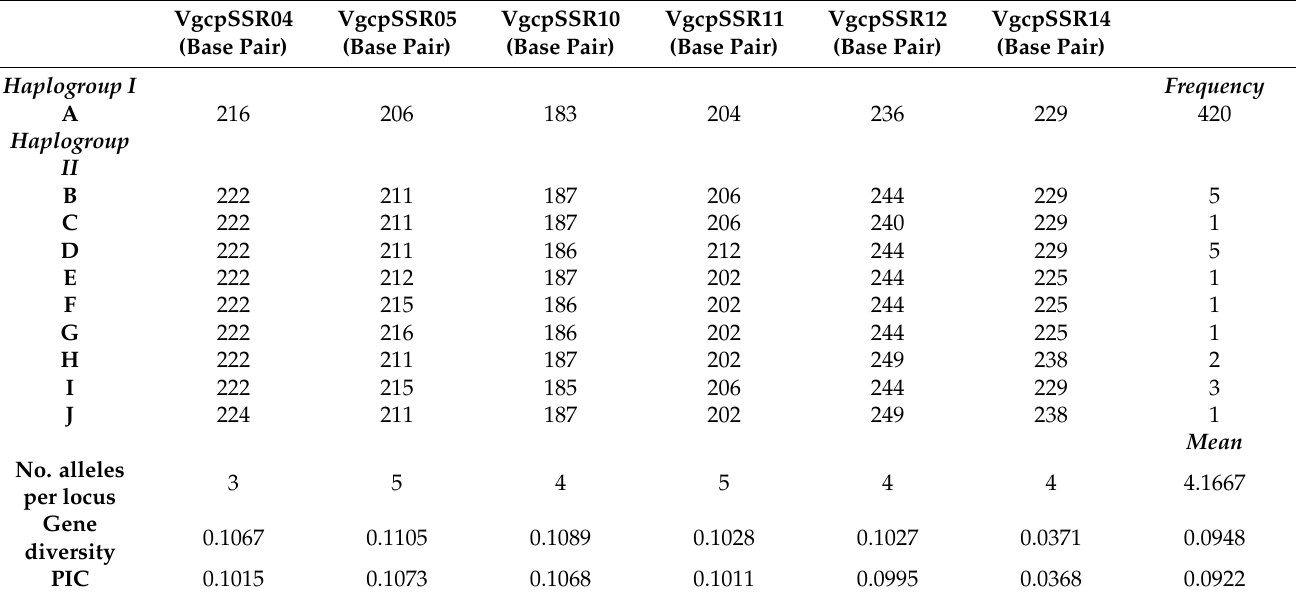
Table 5. Number of alleles, gene diversity, and haplotypes detected in 493 lablab accessions using 6 chloroplast SSR